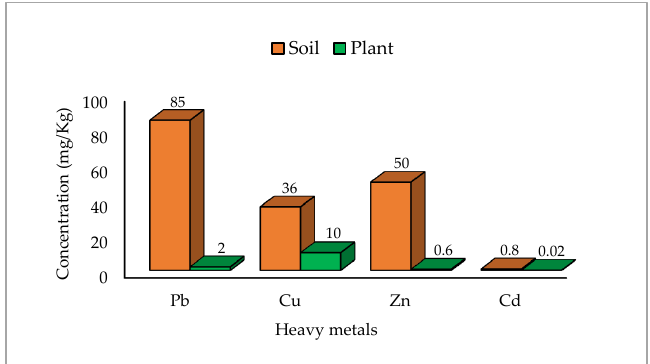
Figure 5. Permissible limits for concentrations of heavy metals in the soil and plants (Modified after WHO [62]) .